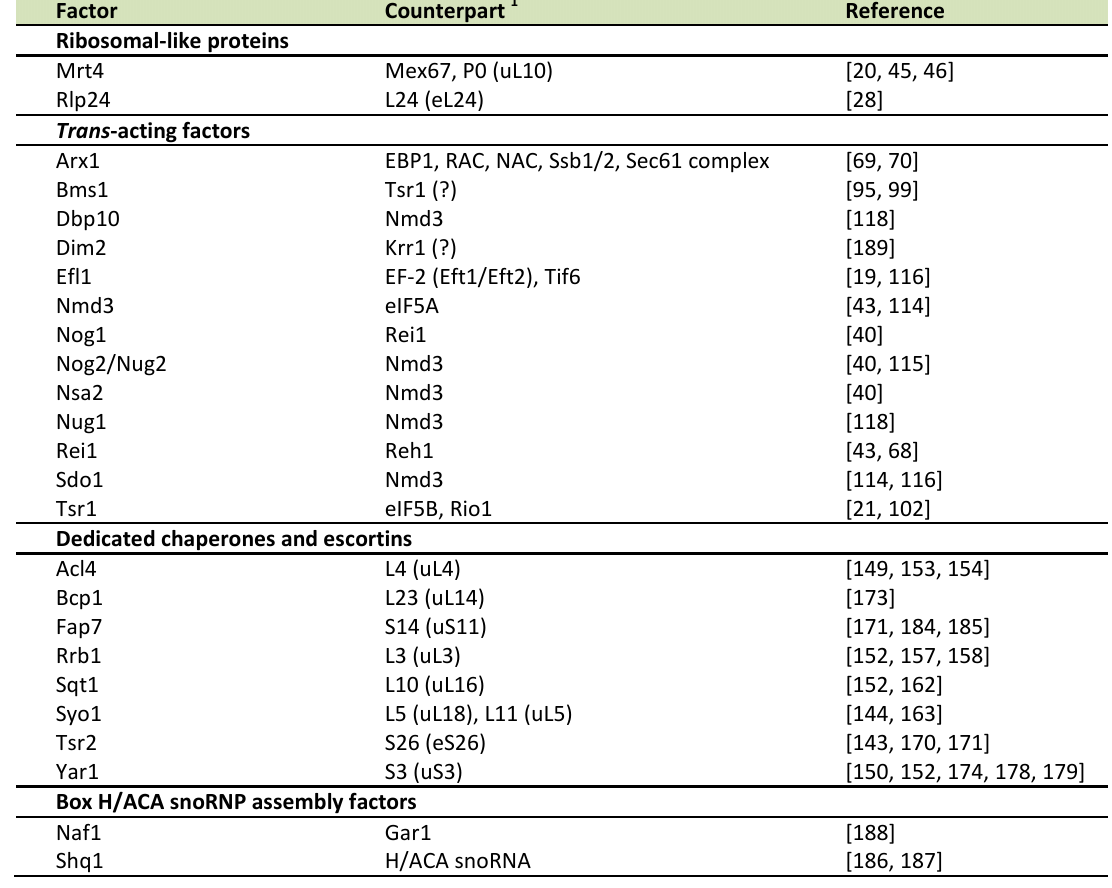
Table 1. Examples of placeholding situations during the ribosome biogenesis